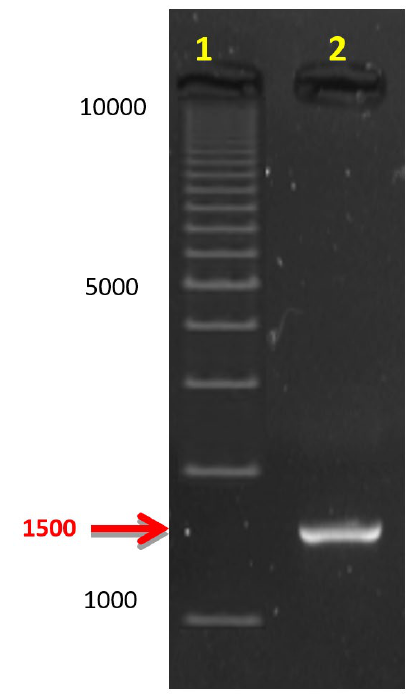
Fig. 2. The 1500 bp 16S rDNA amplicon separated on 0.8% agarose gel electrophoresis compared to DNA Ladder (1kb). Lane 1: 1kb DNA leader (Bio-Rad) and, Lane 2: Amplified gene from keratinolytic bacterial